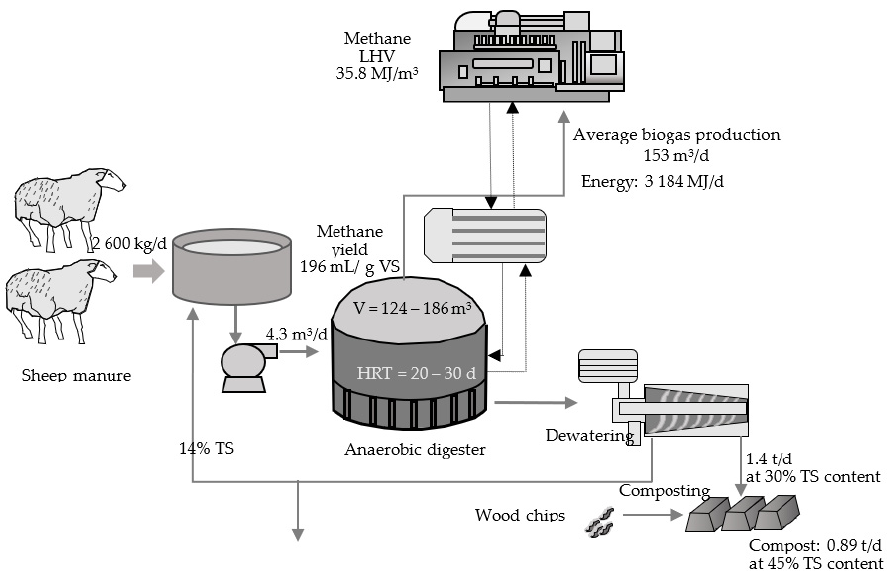
Figure 7. Schematic representation of digestion treatment plant using sheep manure as a single substrate. This plant is assumed to serve one single livestock farm with 2000 animals, working as a wet digestion system.